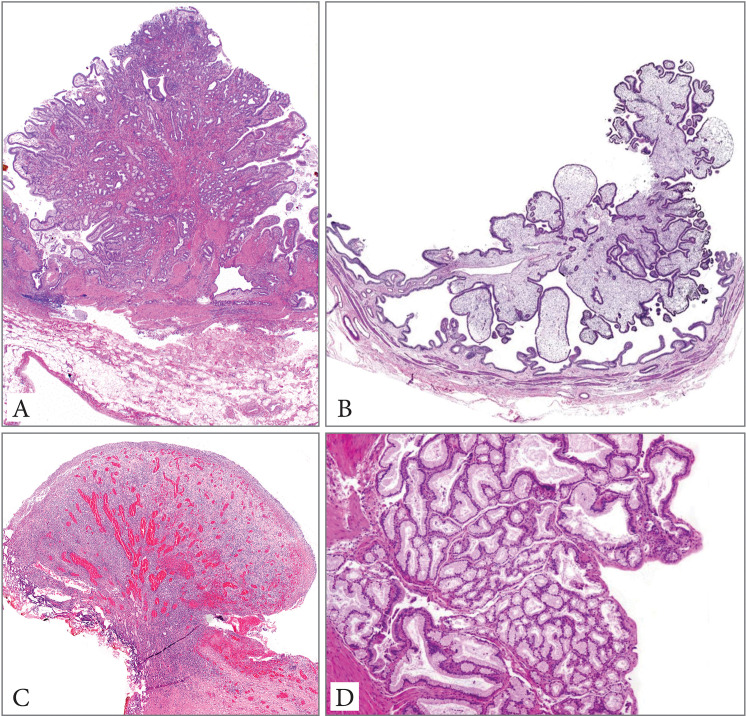
Non-neoplastic polyps: Fibromyoglandular polyp (A), cholesterol polyp (B), inflammatory polyp (C) and polypoid pyloric gland metaplasia (D) (Hematoxylin&eosin, 10x magnification).